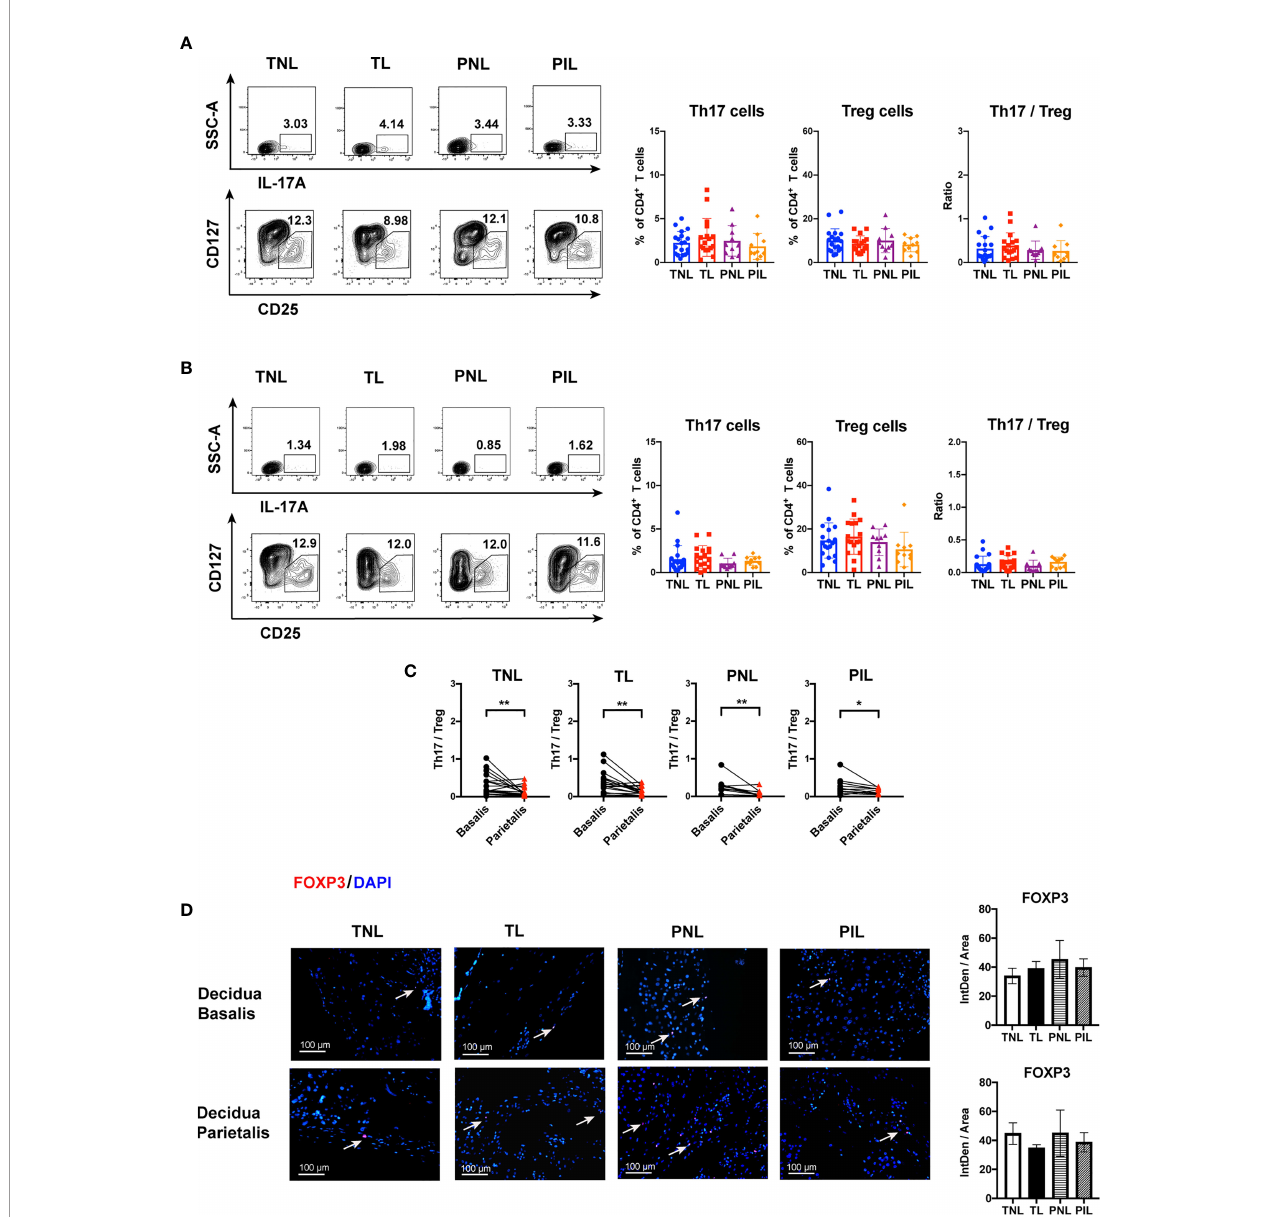
FIGURE 6 | Flow Cytometric Analysis of Th17 and Treg cells, and IF Staining of FOXP3 in the Decidua basalis and Parietalis during Term and Preterm Labor. (A) Comparison of the frequencies of Th17 and Treg cells as well as Th17/Treg ratio among the four groups in the decidua basalis; (B) Comparison of the frequencies of Th17 and Treg as well as Th17/Treg ratio among the four groups in the decidua parietalis; (C) Comparison of Th17/Treg ratio between the decidua basalis and parietalis among the four groups respectively; (D) Comparison of the expression of FOXP3 (Red) in the decidua basalis and parietalis among the four groups, the nuclei were stained with DAPI (blue) and the positive staining was indicated by the white arrow. Continuous variables were presented as mean ± standard deviation. Mann-Whitney U test was used for comparison between two groups, Wilcoxon matched-pairs signed rank test were used for comparison between decidua basalis and parietalis. Differences are indicated: * P < 0.05, ** P < 0.01. TNL group, N = 19; TL group, N = 17; PNL group, N = 10; PIL group, N = 10. IntDen: Integrated